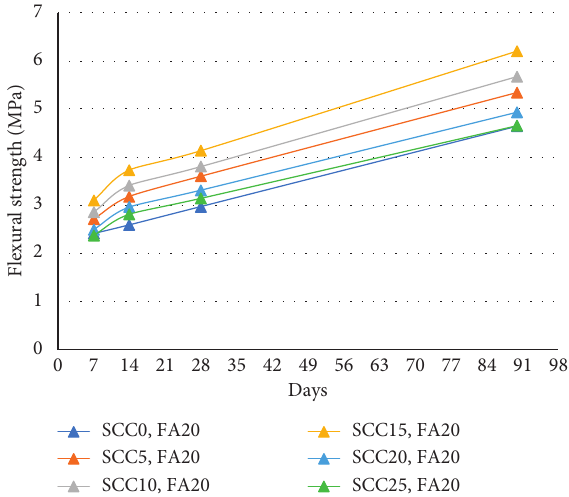
Figure 10: Flexural strength test results for concrete mixes with 20% replacement of fly